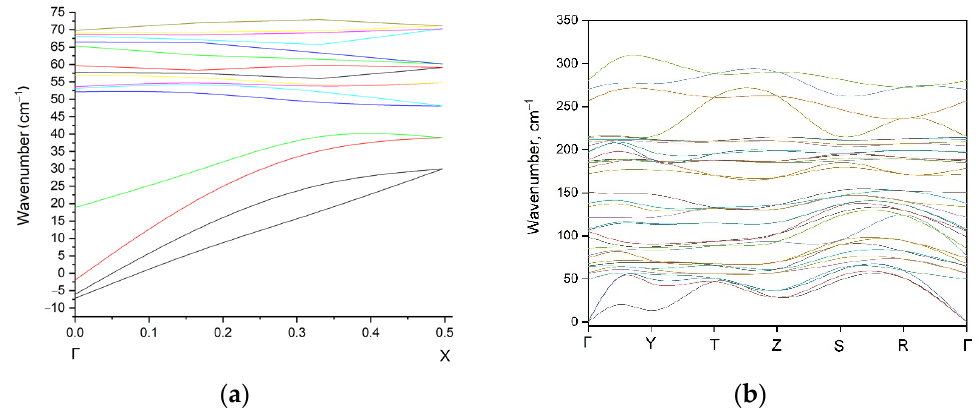
Figure 4. Calculated phonon dispersion curves of EuScCuSe 3 in ( a ) Pnma and ( b ) Cmcm structures.